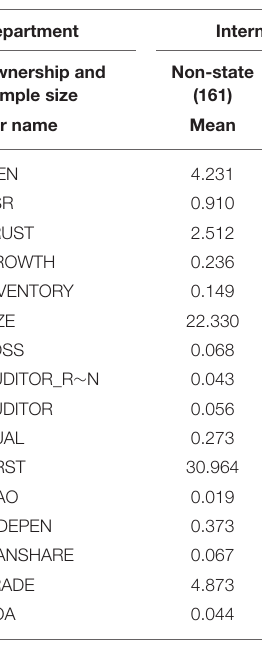
TABLE 3 | The t -test between state-owed and non-state-owned firms.